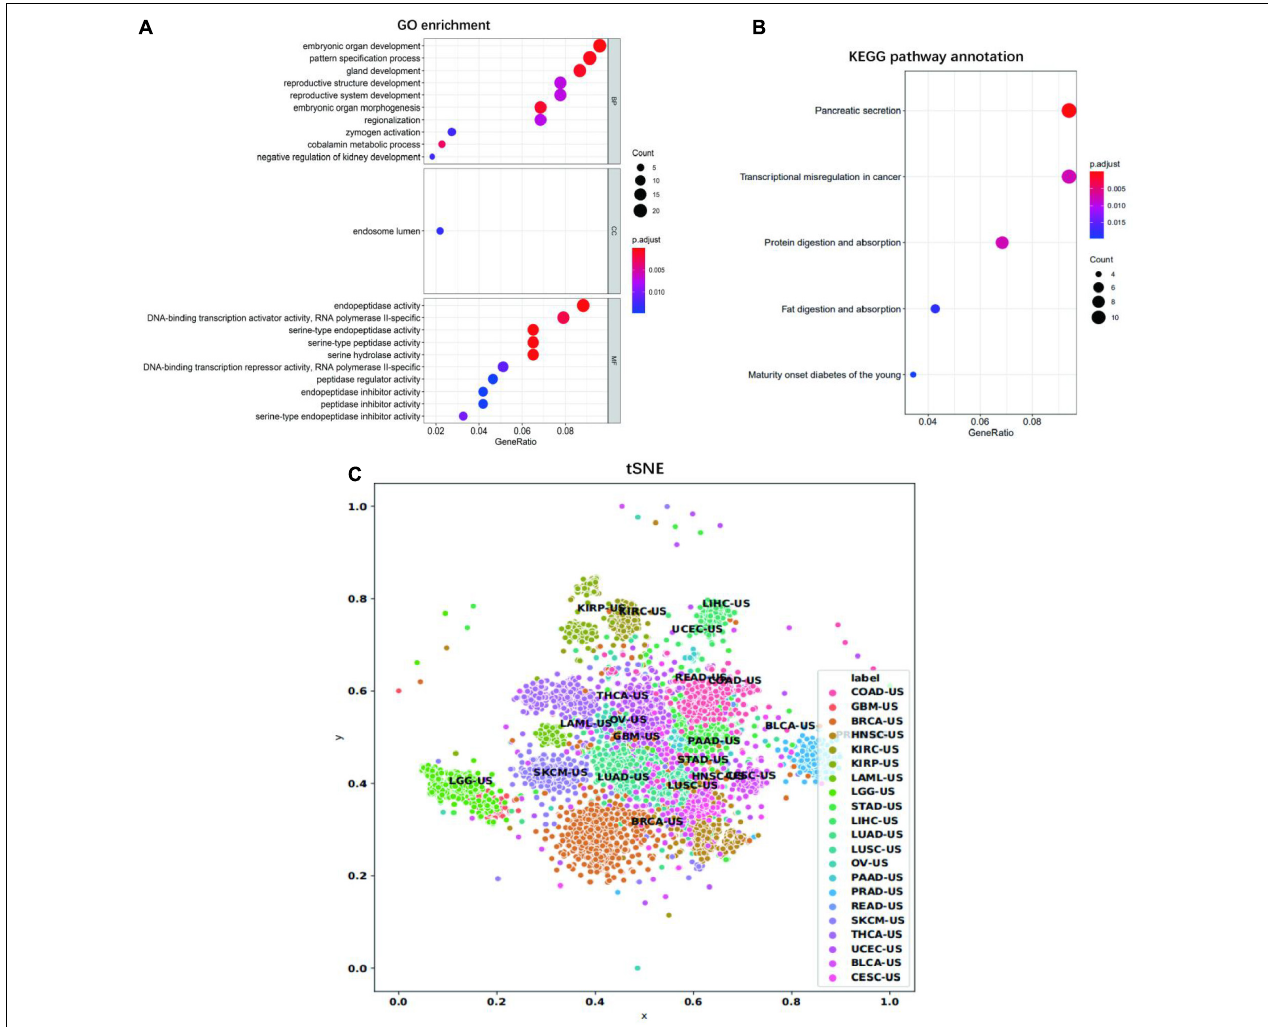
FIGURE 5 | GO and KEGG analysis. (A) Significantly enriched GO cellular component, biological process, and molecular function of selected 14 top-ranked genes of each cancer type in gene expression data. (B) Significantly enriched KEGG pathways of the selected 14 top-ranked genes of each cancer type in gene expression data. The dot plot shows the number of signature genes identified by enrichment analysis for each cell component, biological process, molecular function, and KEGG pathway. The dot size represents the number of genes enriched in specific pathways and the dot color represents adjusted enrichment p -value. (C) The tSNE visualization of all samples for the 21 tumor types. The x - and y -axis represent the first and second dimension of tSNE,